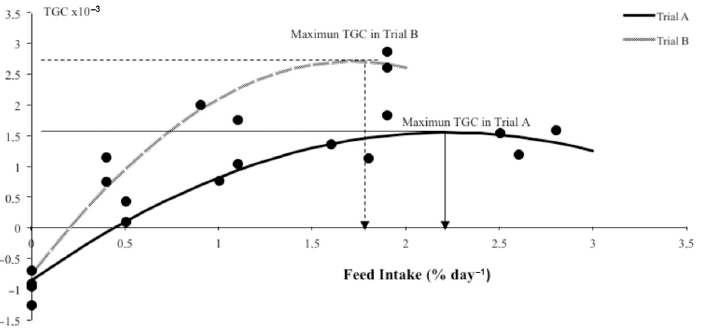
Figure 1. Thermal growth coefficient (TGC) response to increasing levels of feed intake (FI) and response curve of quadratic models considering trial A and trial B in meagre.